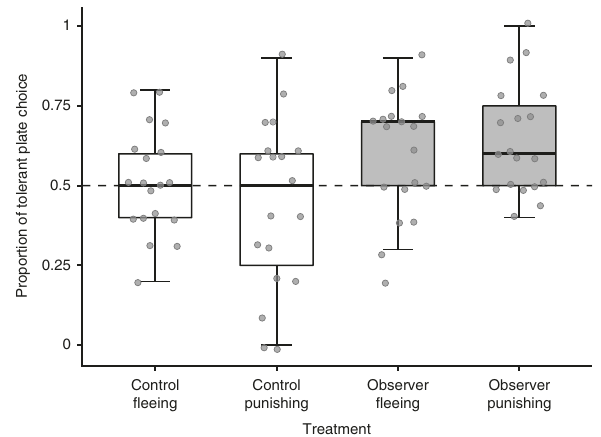
Fig. 3 Socially learned preference for tolerant clients. Juvenile cleaners ’ proportion of choosing the plates that were tolerant (non-responsive to cleaners eating preferred prawn items) in the social learning phase of experiment 2. Dashed lines mark the preference score expected if juveniles chose at random between the tolerant and the responsive plate (0.5). Observer treatments (in grey): juveniles had witnessed adult demonstrators inducing one of the two plates to either fl ee or punish (chase the cleaner) in response to cleaners eating a preferred prawn item. Control treatments (in white): the same plates had been presented for similar amounts of time and removed in similar ways but without the demonstrators being able to eat off them (a transparent barrier prevented the demonstrator from approaching the plate, see Fig. 1). N = 19 individuals that participated in all treatments. Boxplots show the median and interquartile range, whiskers denote 1.5 × interquartile range and dots mark individual data points. Source data are provided as a Source Data fi